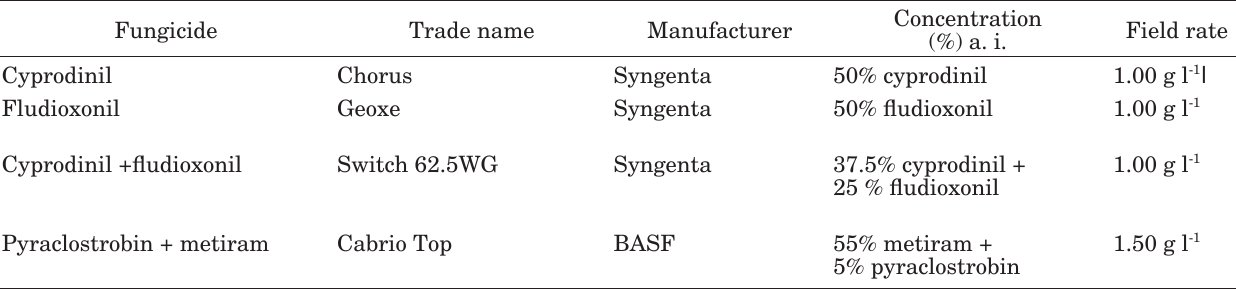
Table 1. Details of fungicides tested to control grapevine wood fungi in commercial nurseries.